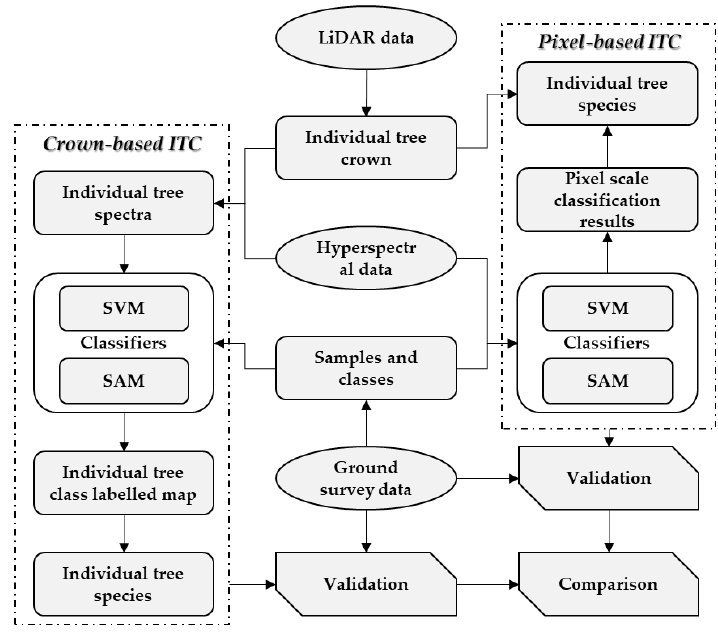
Figure 3. Flowchart of the individual tree species identification method.